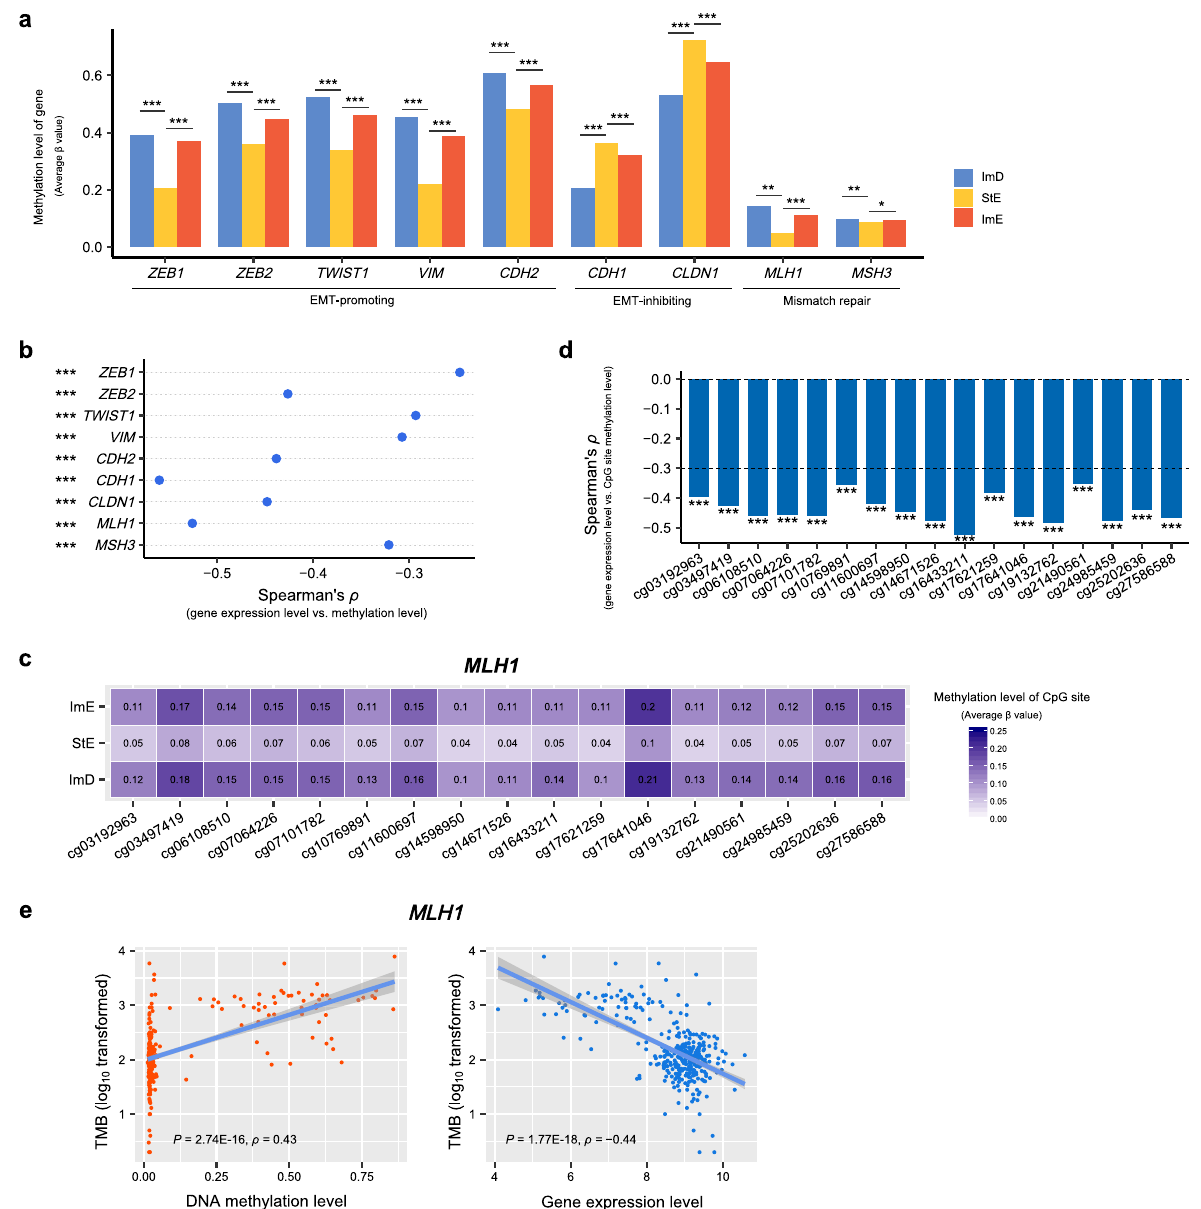
Fig. 5 Comparisons of DNA methylation pro fi les between the three GC subtypes in TCGA-STAD. a The EMT-promoting, EMT-inhibiting, and DNA mismatch repair genes displaying signi fi cantly different methylation levels between the three GC subtypes. The one-tailed Mann – Whitney U test P values are indicated. b Correlations between expression levels and methylation levels of the genes whose methylation levels are signi fi cantly different between the three GC subtypes. c 17 CpG sites within MLH1 CpG islands having signi fi cantly lower methylation levels in StE than ImD and ImE. The methylation levels (average β values) are shown. d Spearman correlations between MLH1 expression levels and the methylation levels of its 17 CpG sites, which have signi fi cantly lower methylation levels in StE than ImD and ImE. e Spearman correlations between TMB and MLH1 methylation levels and expression levels. * P < 0.05, ** P < 0.01, *** P <